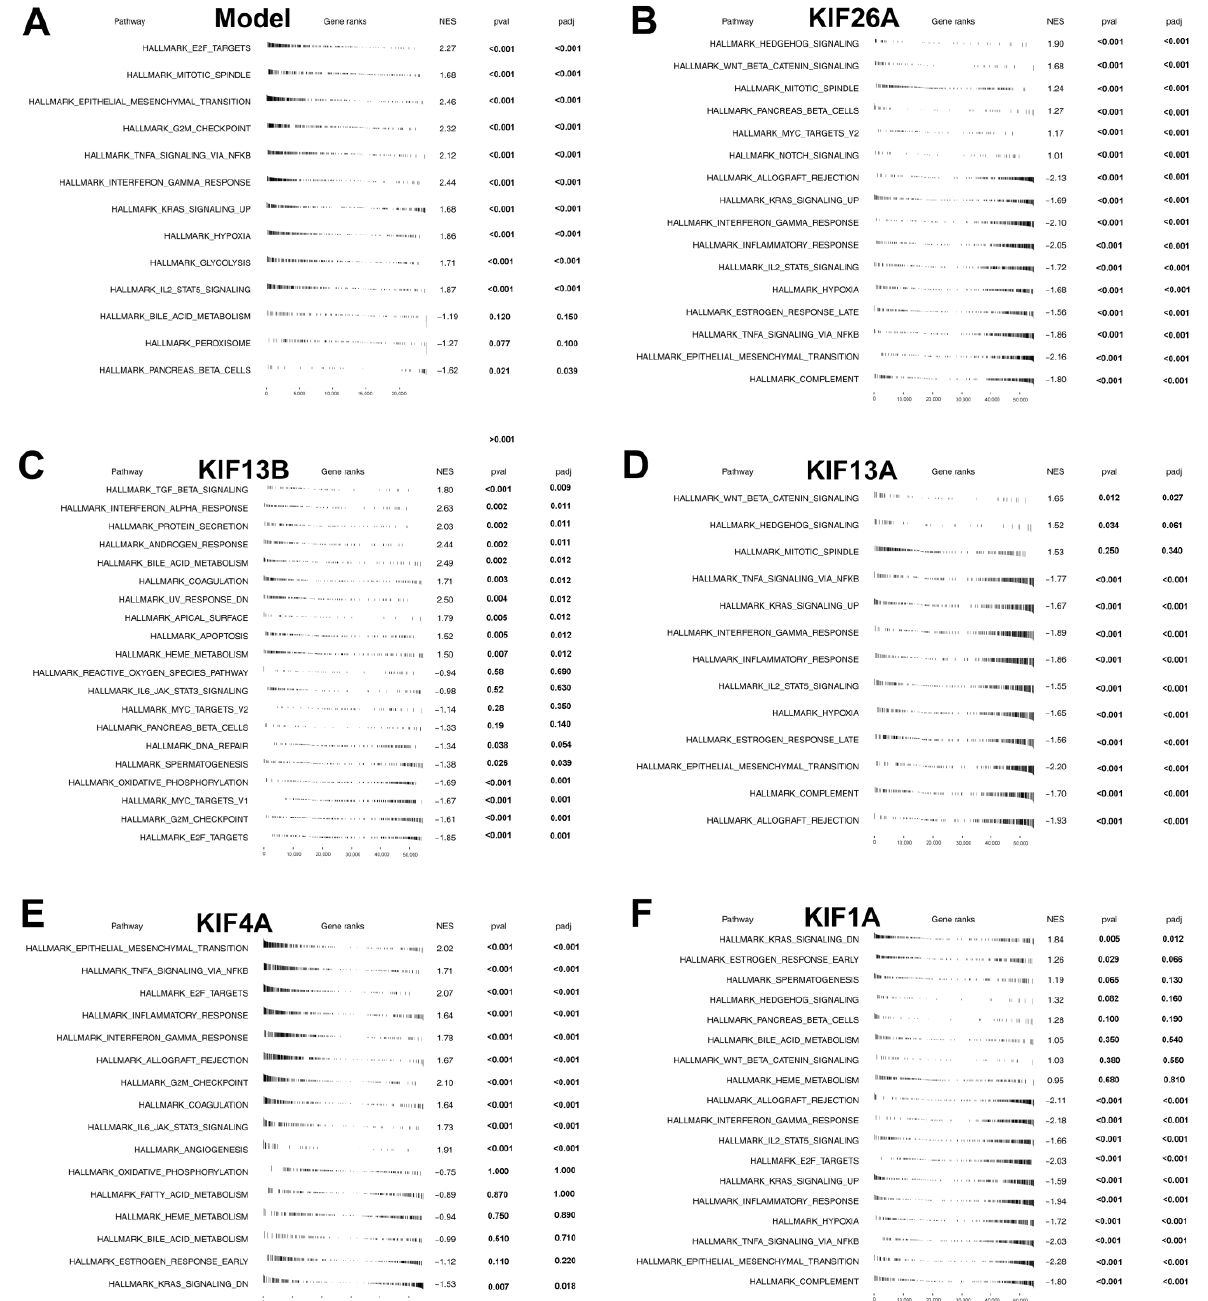
Figure 5. Pathway enrichment analysis. Notes: ( A ) GSEA analysis was performed to explore biological pathway differences between high- and low-risk patients; ( B – F ) patients were classified into high-expression and low-expression groups based on the median expression of 5 KIFs, and GSEA analysis was performed to explore biological pathway difference between high-expression and low-expression patients.